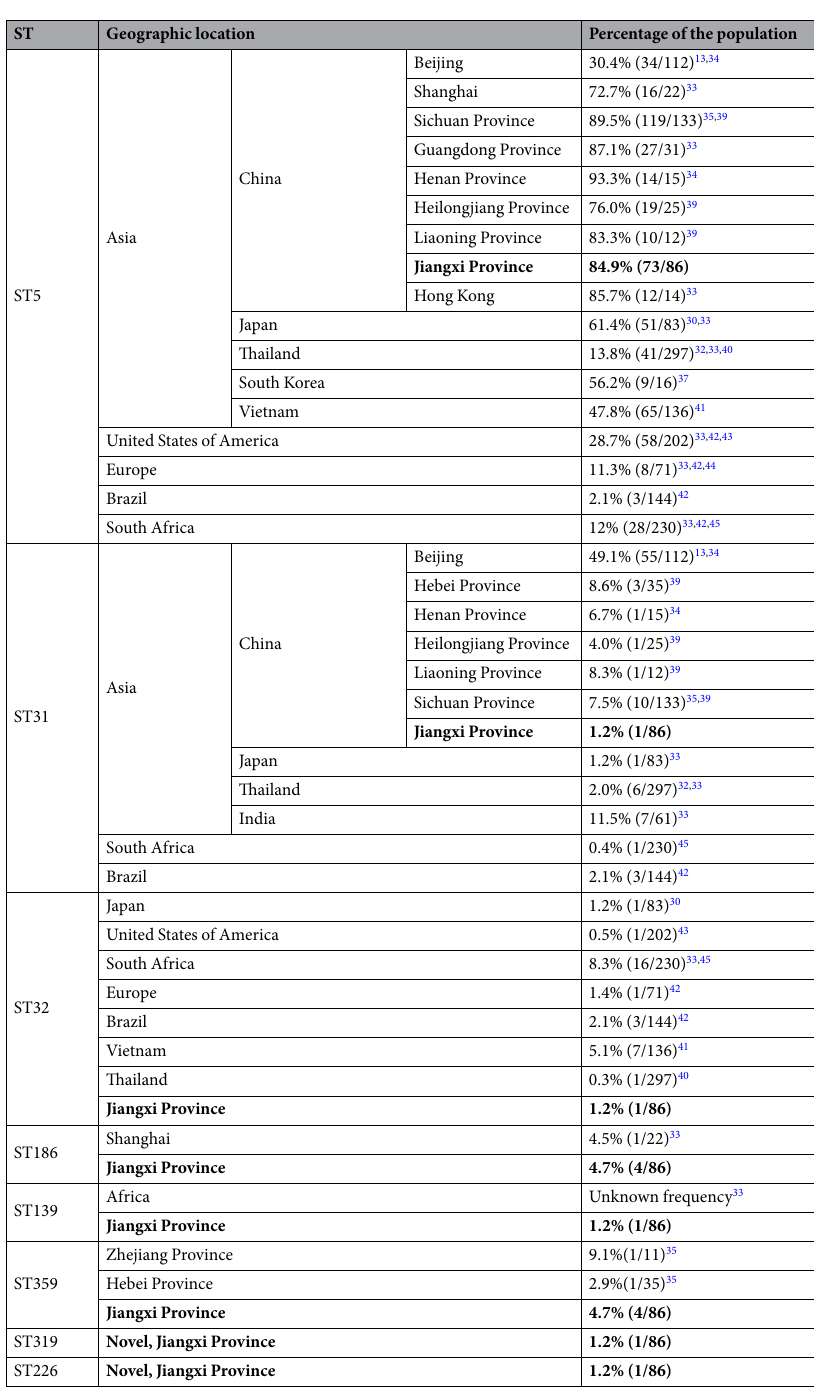
Table 3. Summary distributions of the eight sequence types identified in Jiangxi Province in other parts of the nucleotides at one ( GPD1 ) of the seven sequenced loci (Fig. 1 and Table 2). Similarly, ST31 and ST32 were very close to each other, differed from each other by a few nucleotides at the PLB1 locus. Overall, these five STs formed a tight cluster with each other. In contrast, the other three STs (ST139, ST226, and ST319) were more distantly related to each other and to those five STs described above based on the concatenated gene sequences at these seven loci. Relationships Among Geographic Populations of C. neoformans in China. The multilocus geno- types of all isolates from China in the Cryptococcus MLST database were retrieved. A total of 385 isolates from